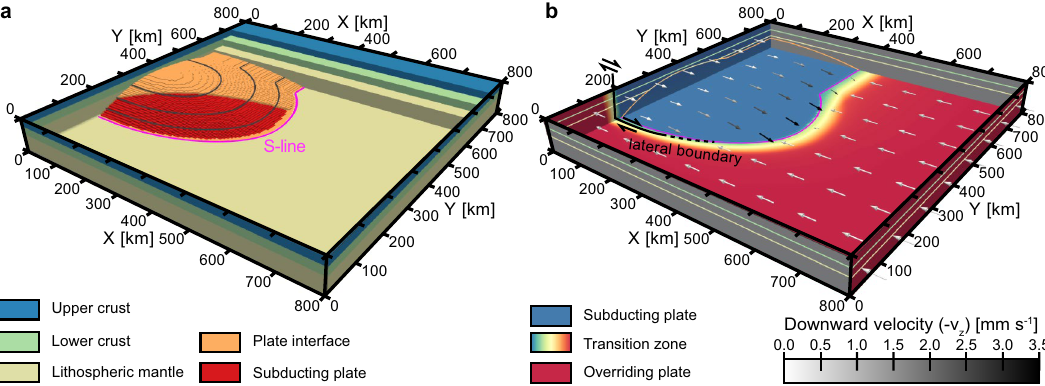
Figure 2. 3D view of the model setup. ( a ) Material layout: a vertically layered overriding plate with upper crust, lower crust, and lithospheric mantle is underlain by a subducting plate with a cylindrical slab and a convex- upward-shaped indenter in the back and middle part of the model box, respectively. To emulate the asymmetric geometry of the southern Alaskan plate corner, the indenter bulge curves strongly towards the front part of the model, where the subducting slab is absent, in contrast to previous studies that assumed a symmetric model configuration 15–17,24 . The shape of the indenter is highlighted by gray isolines. The overriding and subducting plates are separated by a rheologically weak interface layer. To better illustrate the internal structure of the model, the plate interface is not shown in the lower part of the indenter. The S-line represents the intersection of the downgoing plate with the bottom of the model domain. ( b ) Velocity boundary conditions: the horizontal velocities applied to the left and right sides of the model box cause the overriding plate to move horizontally in the negative X-direction (red color), while the subducting plate moves in the opposite course (blue color). The inflow of lower plate material is mass-balanced by a vertical outflow through the bottom surface, which gradually increases from the left side of the model towards the S-line (see the downward component of the velocity vectors shown in shades of gray), corresponding to a rotational motion of the subducting slab. The resulting relative motion of the overriding and subducting plates along the transitional zone of the weak interface (gradual color transitions) includes convergence (corresponding to the Aleutian Megathrust subduction zone) and dextral transform (the strike-slip Fairweather fault) at the principal (X-perpendicular) and lateral (X-parallel) boundaries of the subducting plate, respectively. See “Methods” for more details on the model